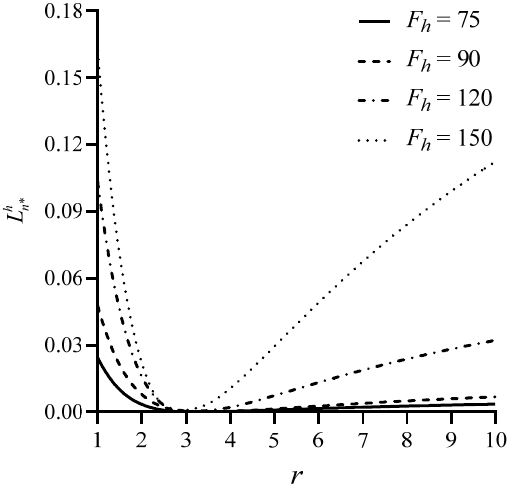
Figure 13. L h n ∗ of (44) for various r and F h in the proposed algorithm.